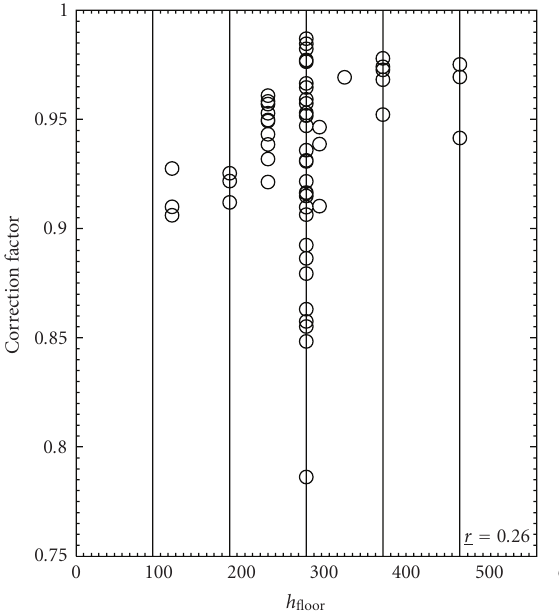
Figure 11: Correction factor variation with AR rib for the set of cho- sen data.